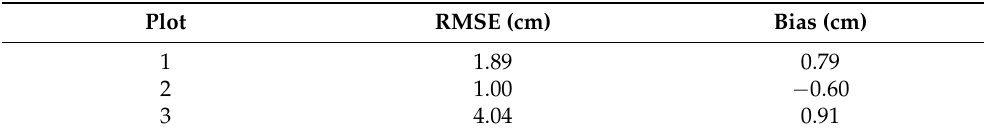
Table 3. LiDAR root-mean-square-error and bias for DBH measurements on trees in three, 400 m 2 , fixed-radius forest inventory